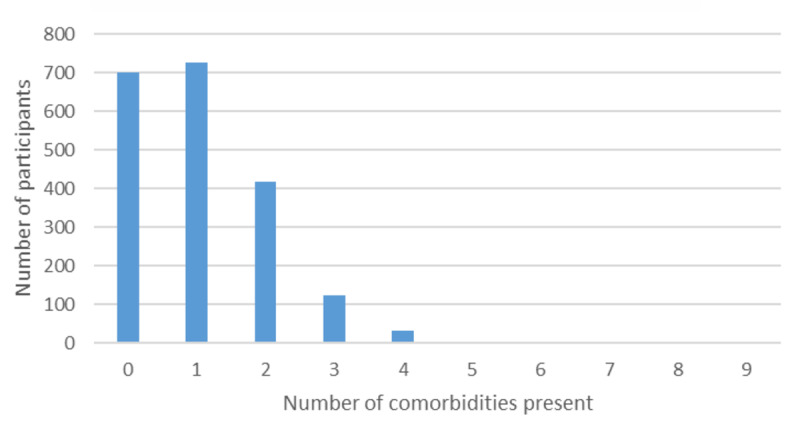
Prevalence of co-exisiting conditions.